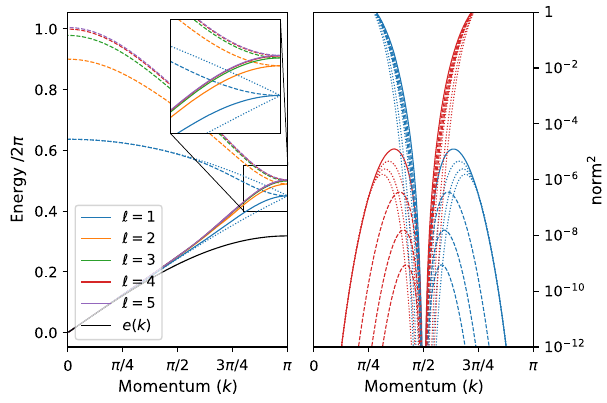
FIG. 3. Left panel: Plots of the eigenvalues 2 l e l ð k Þ of the scaling Hamiltonian (solid lines) and the eigenvalues 2 l ϵ l ð k Þ of the wavelet Hamiltonian (dashed lines) for levels l ¼ 1 ; … ; 5 and wavelet parameters K ¼ 4 , L ¼ 6 . We observe convergence to a fixed-point Hamiltonian. The original dispersion e ð k Þ is shown by the solid black line. The residual off-diagonal interaction between scaling and wavelet modes explains why the eigenvalues e 1 ð k Þ , ϵ 1 ð k Þ deviate slightly from e ð k= 2 Þ , e ð k= 2 þ π Þ (dotted blue lines). Right panel: The single-particle modes obtained from level l ¼ 1 of the wavelet transform, translated back to the original lattice before blocking, should have momentum-space support inside (blue lines) or outside (red lines) the Fermi sea ½ − π = 2 ; þ π = 2 (cid:2) . While the wavelets exactly vanish at the Fermi points, small errors originate from the side lobes on the opposite side of the Fermi points. The solid lines are K ¼ L ¼ 4 . For fixed L ¼ 4 and K ¼ 6 , 8, 10, the support is pushed away from the Fermi surface, but the magnitude of the side lobes does not decrease much (dotted lines). For fixed K ¼ 4 and L ¼ 6 , 8, 10, the side lobes appear to decrease exponentially fast (dashed